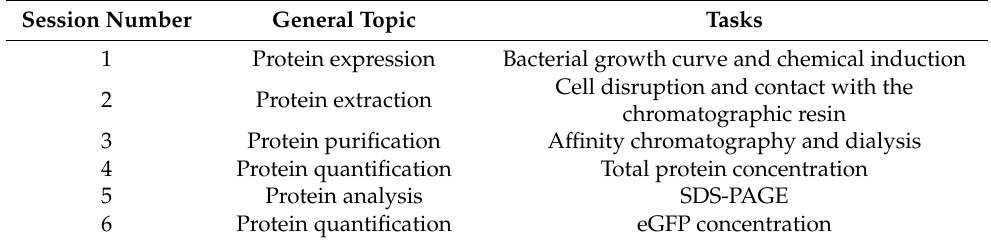
Table 1. Planning of laboratory